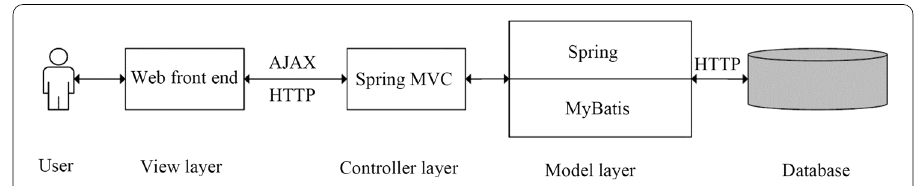
Fig. 3 The overall architecture of the web